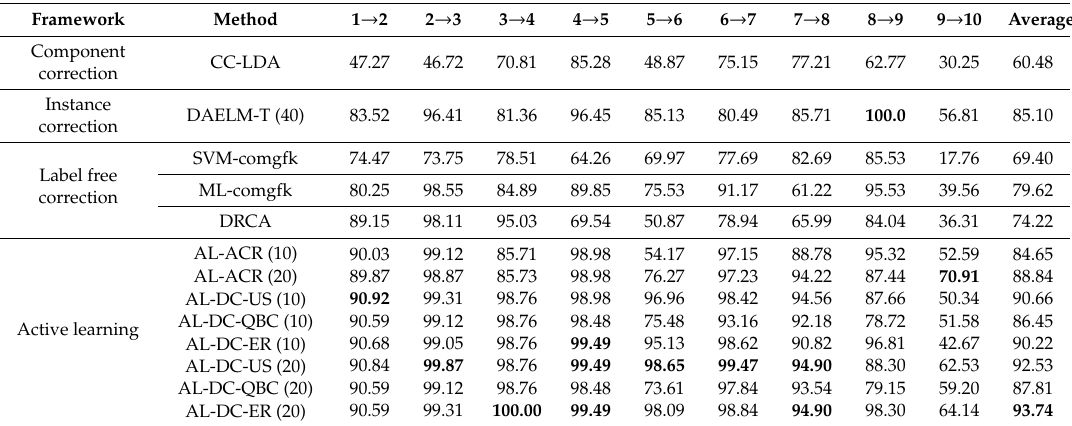
Table 4. Comparison of recognition accuracy in short-term drift